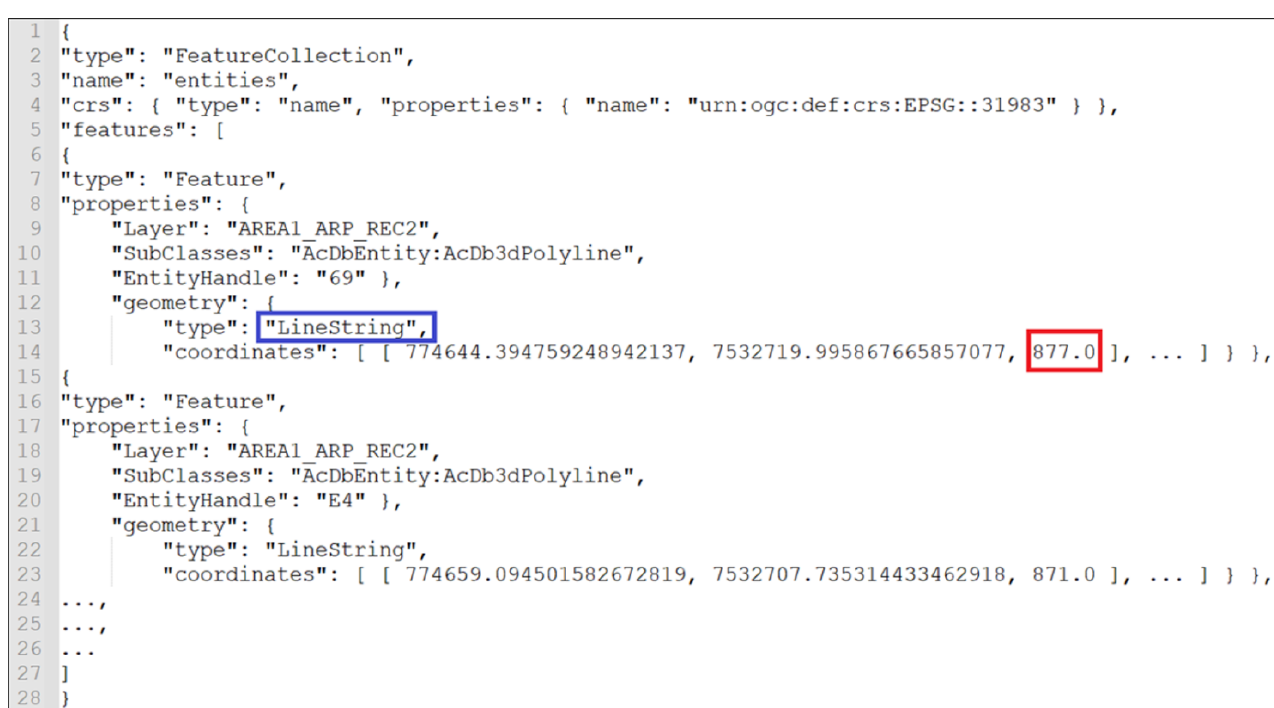
Figure 9. Example of a system input GeoJSON file.